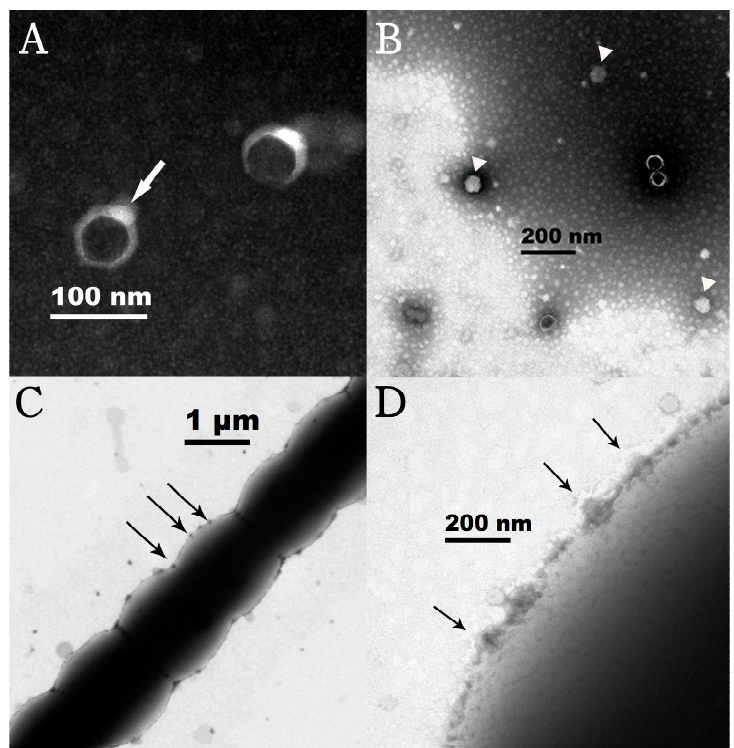
Figure 2. Transmission electron microscopy images of negatively stained free Lbo240-yong1 ( A , B ) and L. boryana FACHB-240 cells absorbed by Lbo240-yong1 ( C , D ). Lbo240-yong1 had an icosahedral head of 50 ± 5 nm in diameter and a short tail of 20 ± 5 nm in length. The white arrow indicates the negatively stained Lbo240-yong1. Black Arrows indicate a large number of cyanophage particles, adsorbed on the surfaces of host cells. White triangles indicate particles are intact and full of DNA.